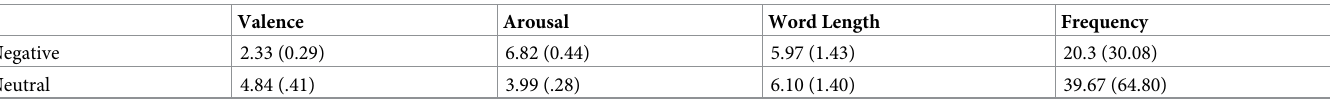
Table 1. Valence, arousal, word length, and frequency for negative and neutral